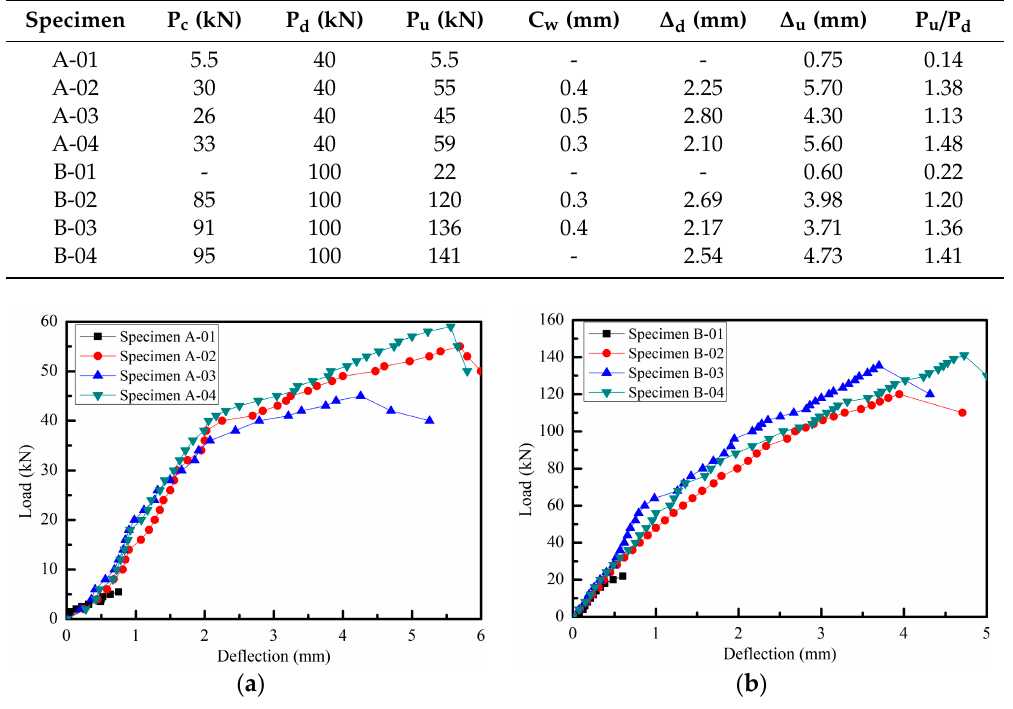
Figure 17. Load-deflection curves of the specimens: ( a ) Group A irregular concrete deep beam specimens; ( b ) Group B irregular concrete deep beam specimens.